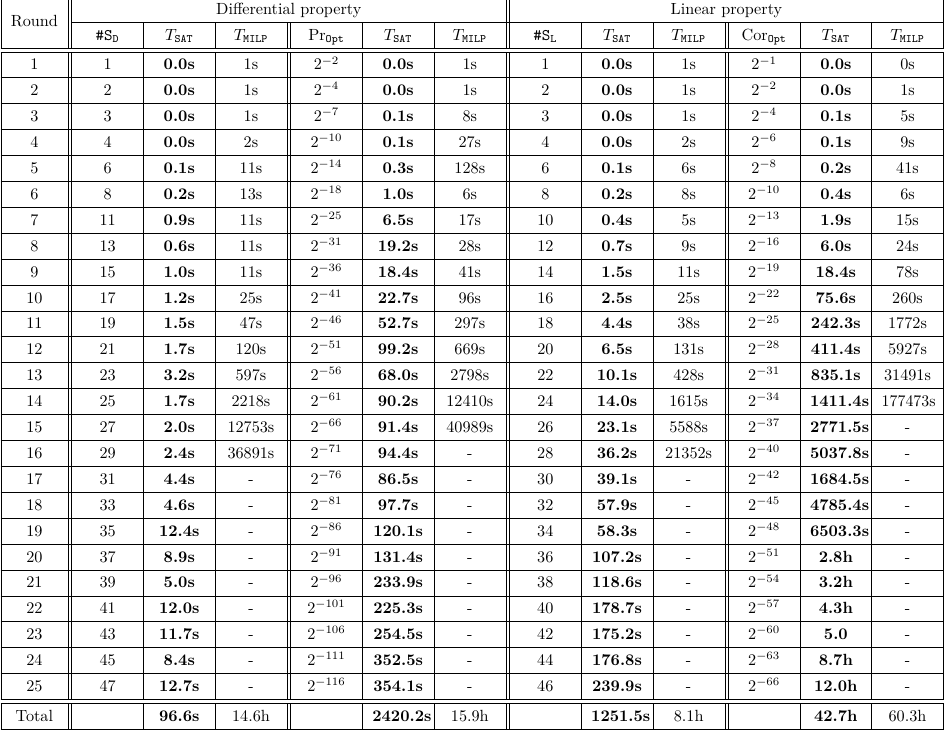
Table 6: Experimental results of RECTANGLE